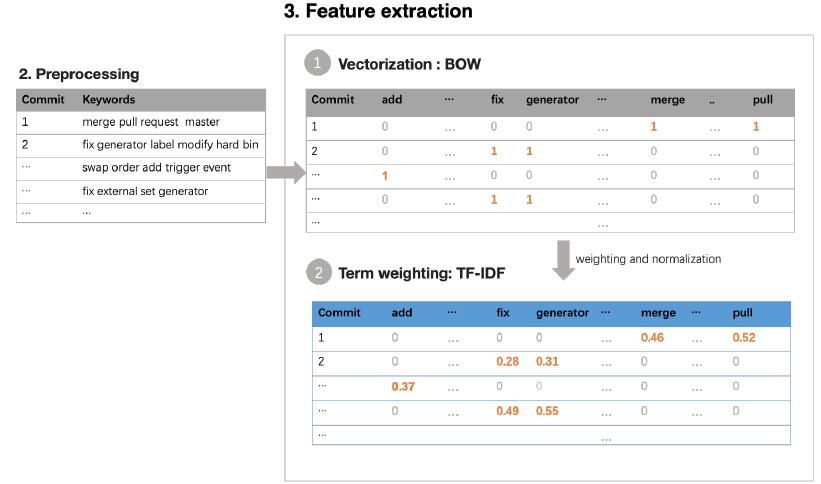
Figure 5. An example of step 3—Feature